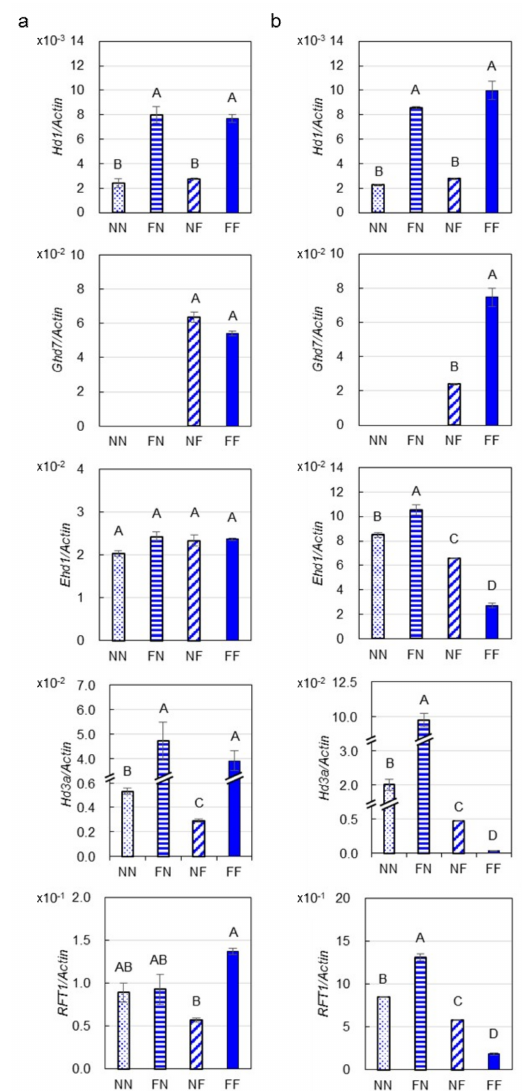
Figure 3. Transcript levels of five heading date genes in the R1-NIL population. ( a ) Under the NSD conditions in Lingshui. ( b ) Under the NLD conditions in Hangzhou. Data are presented in mean ± s. e. m ( n = 3). Bars with different letters are significantly different at p < 0.01 based on Duncan’s multiple range